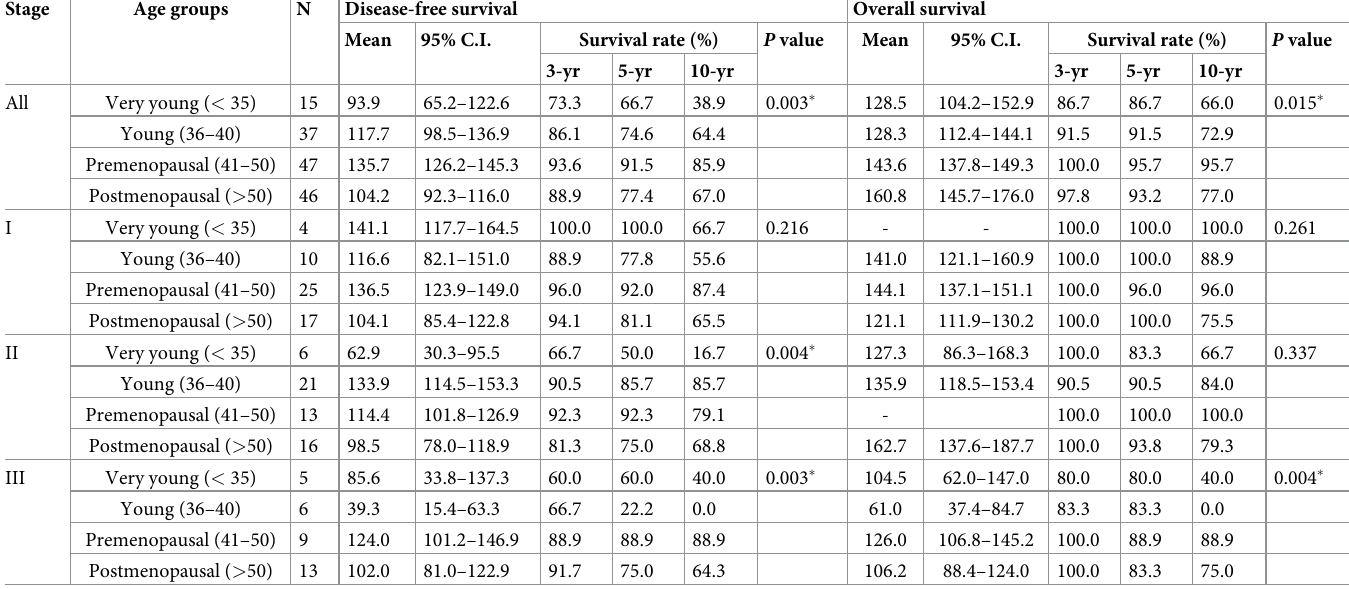
Table 4. Disease-free survival and overall survival rate of patients in different age groups and tumor